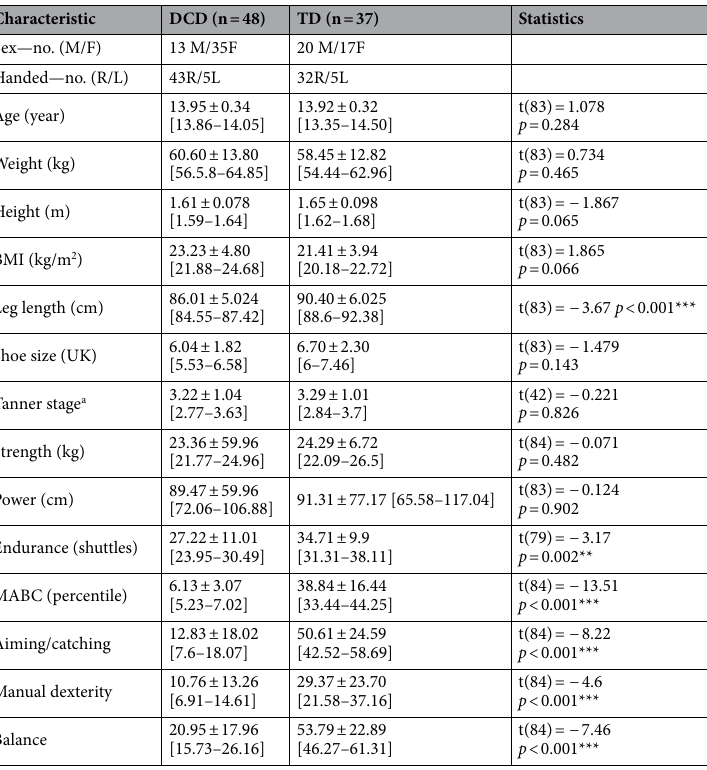
Table 4. Group characteristics and comparisons. Baseline Characteristics of DCD and TD children with comparison. Data shown details mean ± standard deviation [95% Confidence Interval], along with t-statistic (each characteristic showed equal variances among both groups [Levene’s tests were nonsignificant], degrees of freedom, and p -value ( p < 0.01**, p < 0.001***). a Only 44 participants (23 DCD and 21 TD children) indicated their Tanner Stage as many children opted not to disclose this